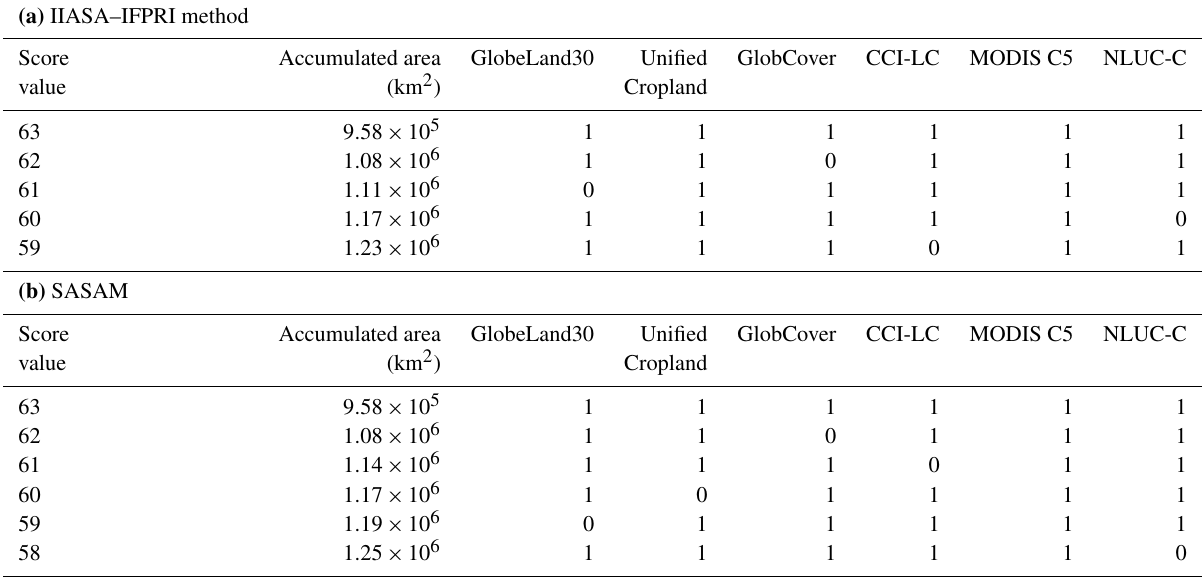
Table 5. Calculation of accumulated areas from high score value to low: (a) IIASA–IFPRI method, (b) SASAM. (a) IIASA–IFPRI